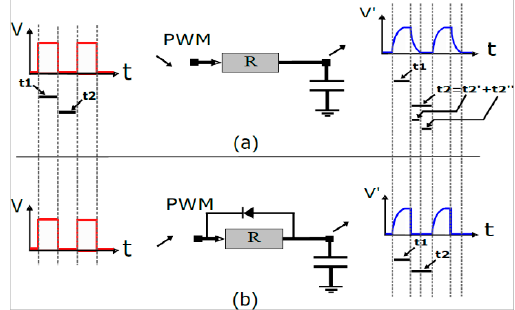
Figure 3. PWM signal with R-C filter: ( a ) R-C filter effect on the PWM signal, and ( b ) R-C filter with the added diode effect on the PWM signal.